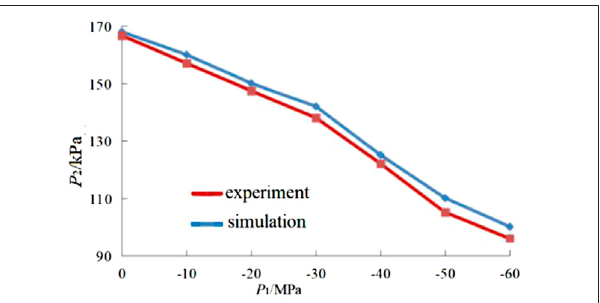
FIGURE 7 | Cavitation characteristics curves under different conditions.